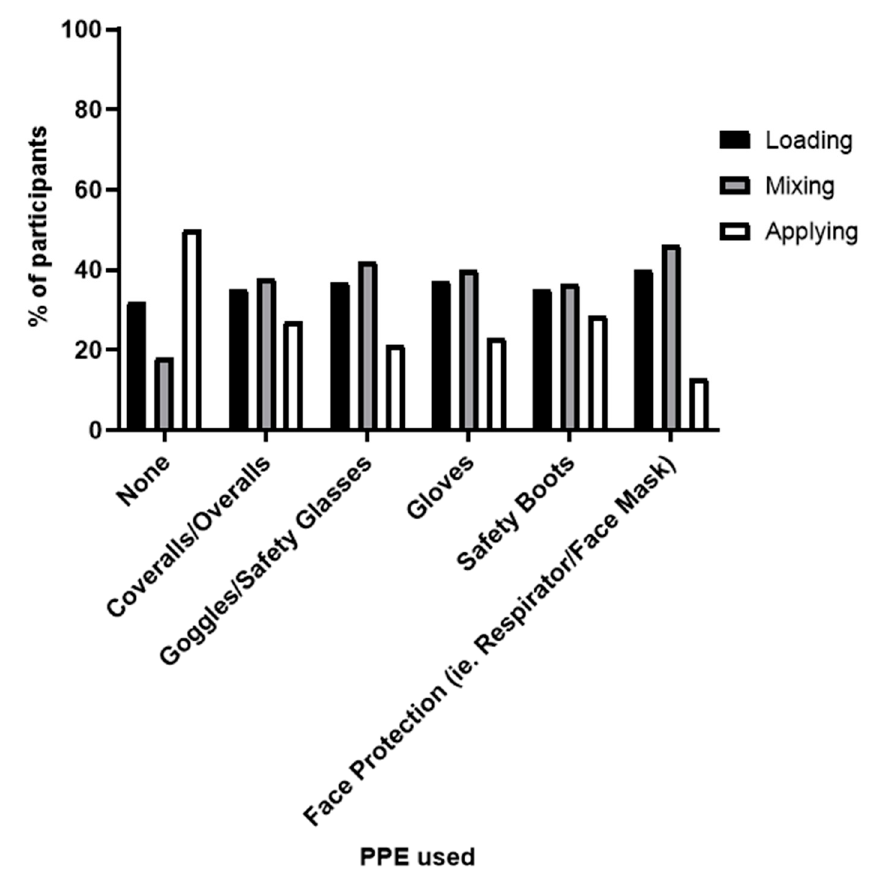
Figure 4. Frequency of PPE usage depending on agrichemical-related task performed—loading, mixing, and applying. N = 42.